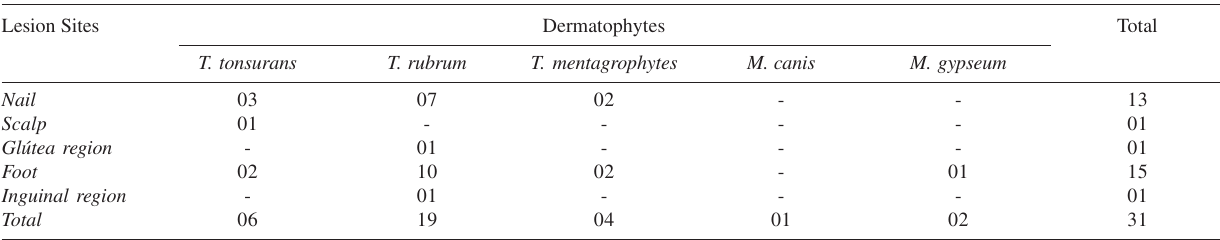
Table 3 - Distribution of dermatophytes isolates by lesion site Lesion